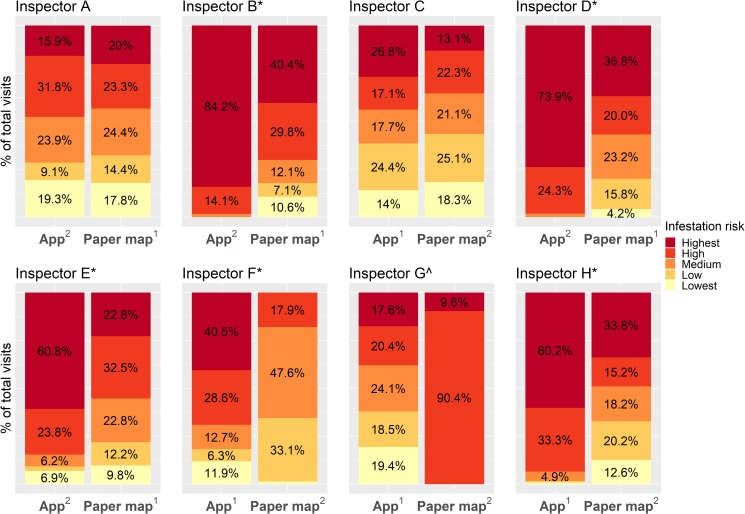
Infestation risk distribution of all houses visited for each inspector.Superscripts in the x axis text indicate arm order (i.e, which medium was used in the first week of the study, and which was used in the second week); values < 4% are not labeled due to space constraints; *p < 0.001, with more higher risk houses visited using the app; ^p < 0.001, with more higher risk houses visited using paper maps.